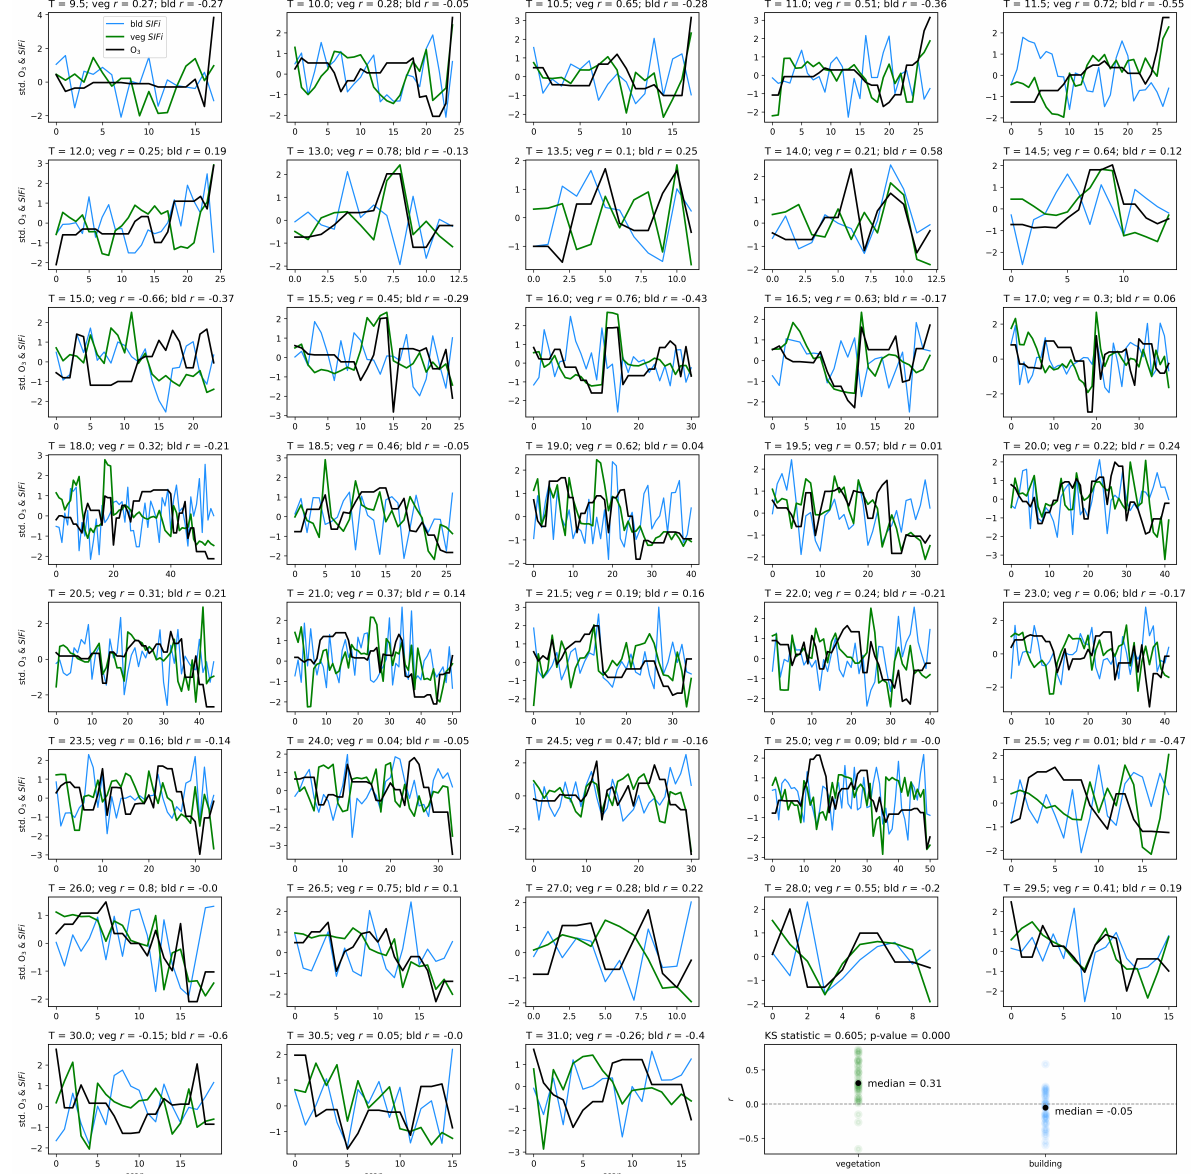
Figure 18. Each plot shows the trends in standardized O 3 concentrations (black), SIFi for vegetation (green), and SIFi for the buildings (blue) for scans of equal temperature. A summary of the Pearson’s correlation coefficients of these time series for both the vegetation and buildings are shown in the figure in the bottom right corner, and indicates a clear correlation between ozone and vegetation health (but not between ozone and building pixels) when temperature is held